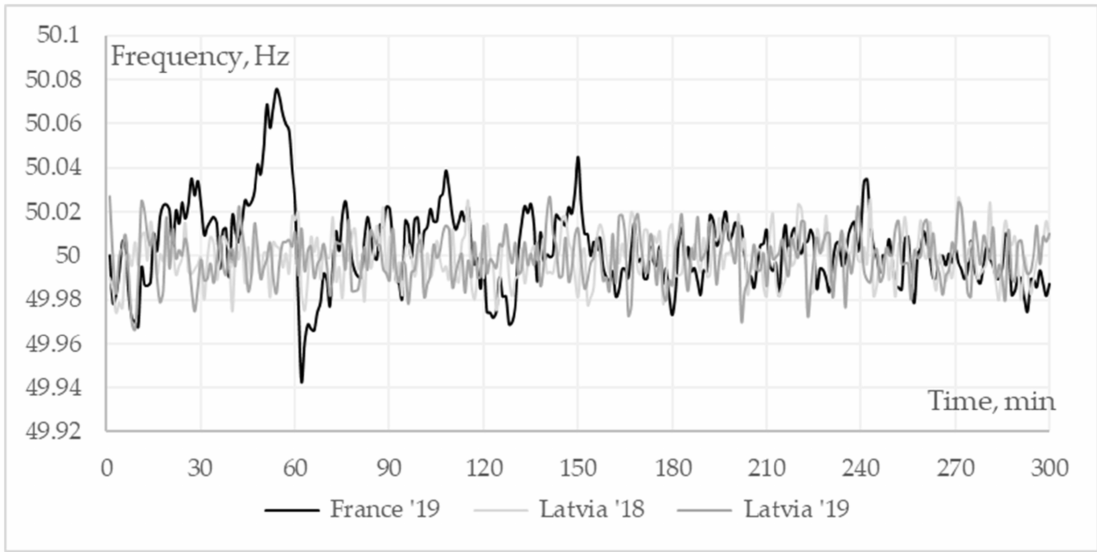
Figure 3. Frequency changes in Latvian and French power systems during 4-h period from 00:00–04:00 in 5 February.